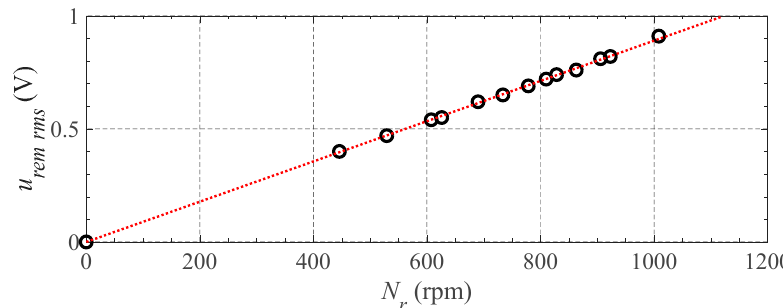
Figure 3. Induced remnant voltage of the induction machine for different rotational speeds.